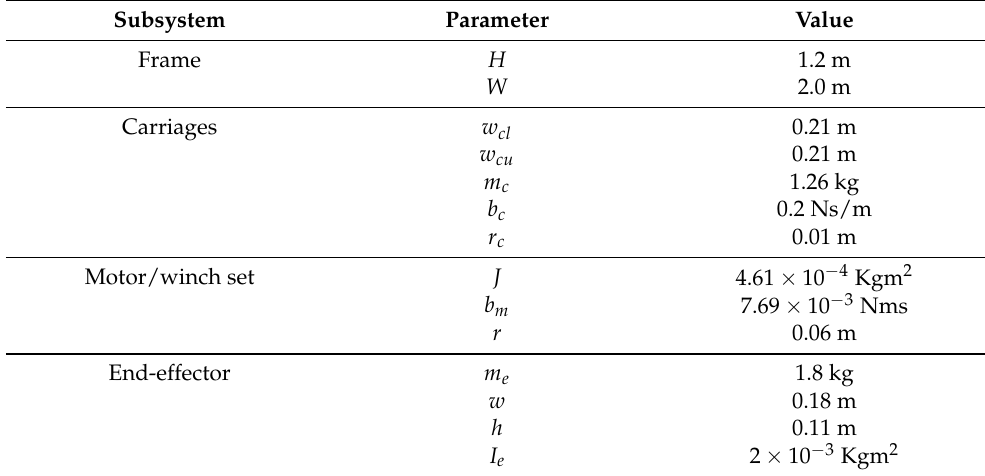
Table 2. Prototype parameters.